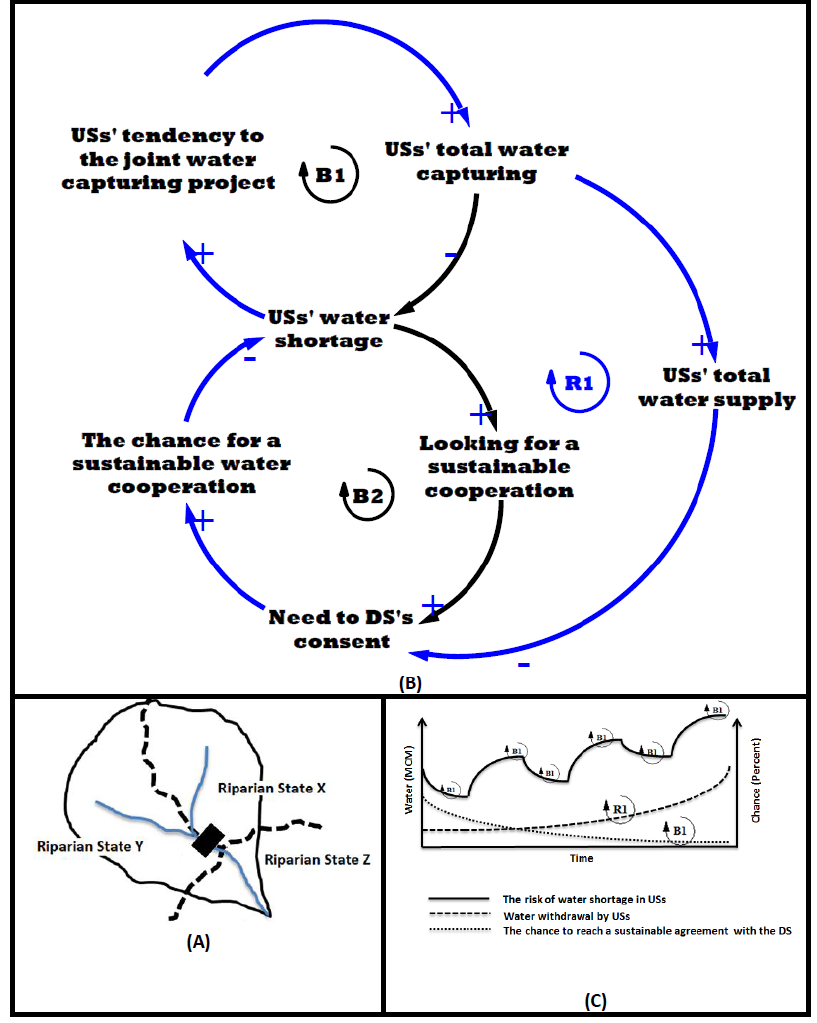
Figure 4. ( A ) The schematic of the physical environment that can embrace HSA4 (real cases